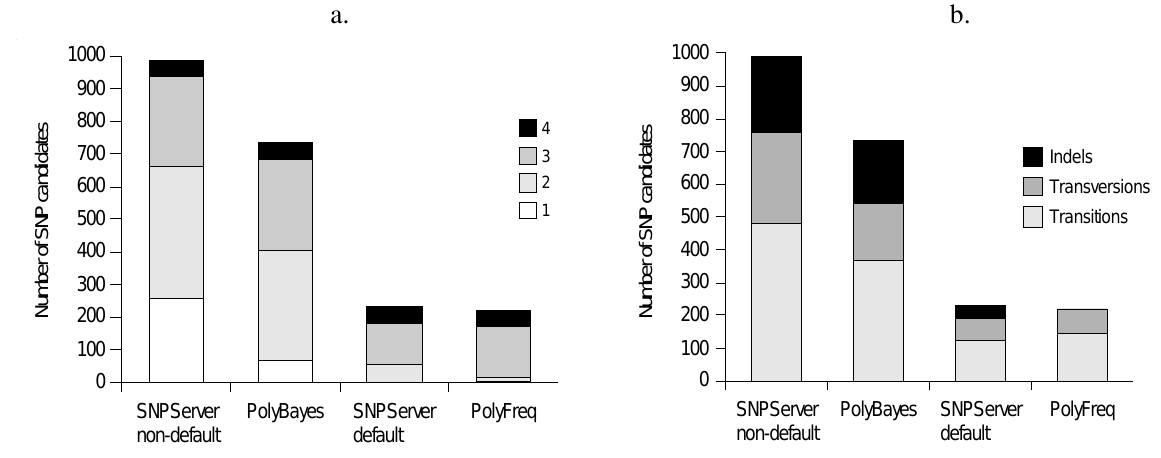
Fig 2: Repartition of the candidate SNPs by tool. a. Repartition by the number of tools by which SNP candidates are detected. b. Repartition by the number of transitions, transversions indels that are